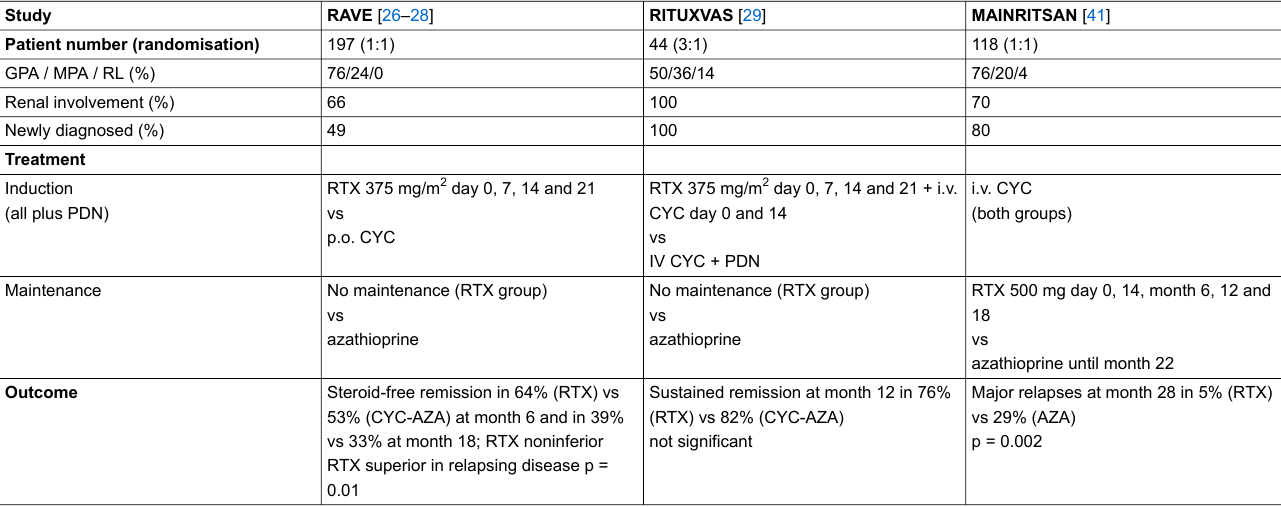
Table 1: Summary of results from randomised trials on rituximab in antineutrophil cytoplasmic antibody-associated vasculitis. Study RAVE [26–28] Patient number (randomisation)